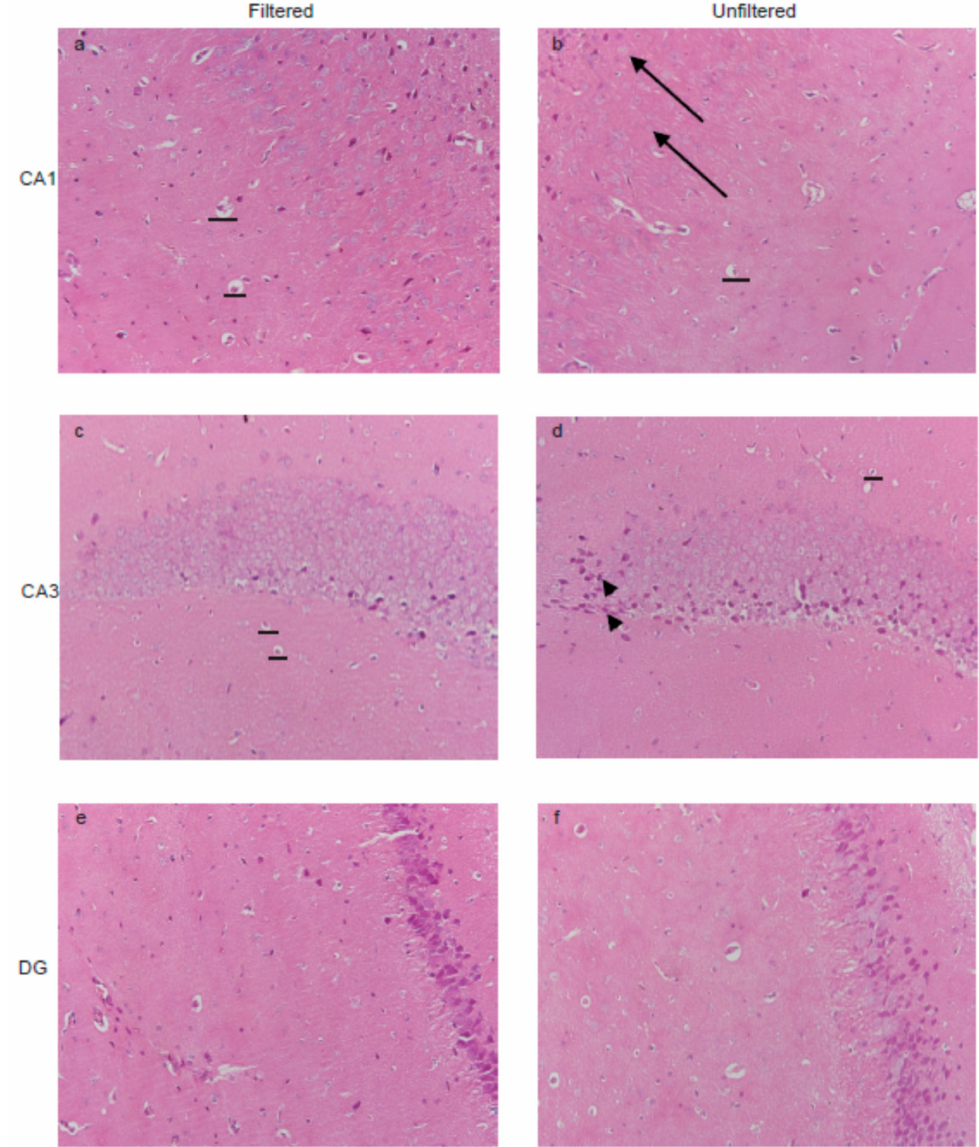
Figure 3. Effects of PM 2.5 exposure on pathological changes. ( a , b ) PM 2.5 exposure resulted in the degenerating neurons (no visible nucleolus) (arrowhead) in CA1 region; ( c , d ) The unfiltered mice showed the nuclear condensation and pyknosis in CA3 region; ( e , f ) The granule cells of DG region was decreased after PM 2.5